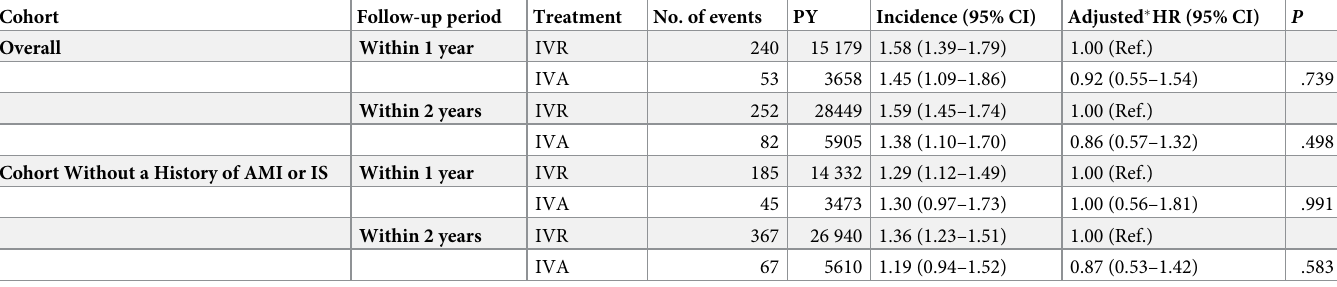
Table 2. Incidence (per 100 PY) and adjusted HR of ATEs during 1- and 2-year follow-up periods. Cohort Follow-up period